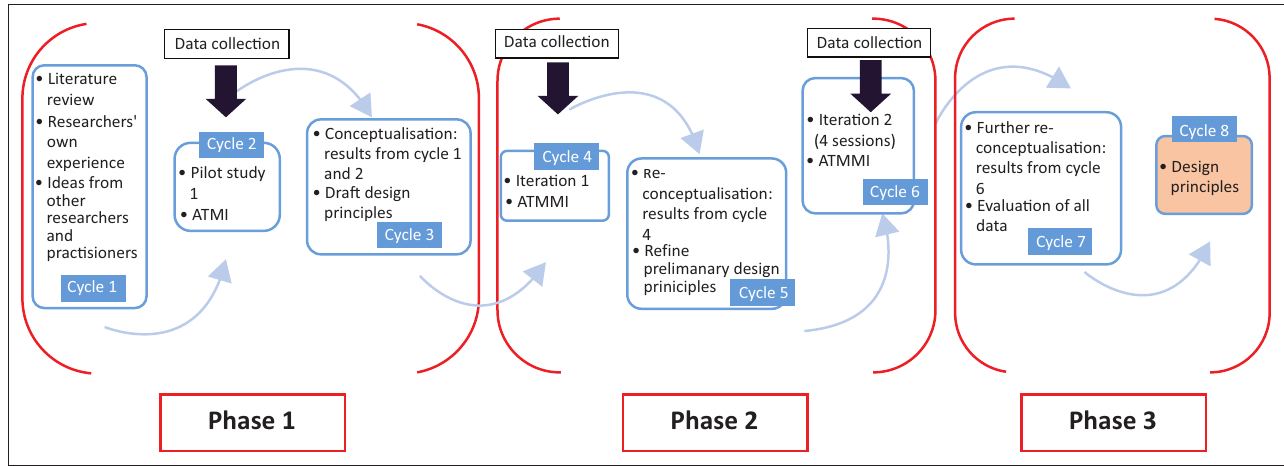
FIGURE 2 : The cyclic process of design-based research (DBR) in this study structured over three phases involving eight